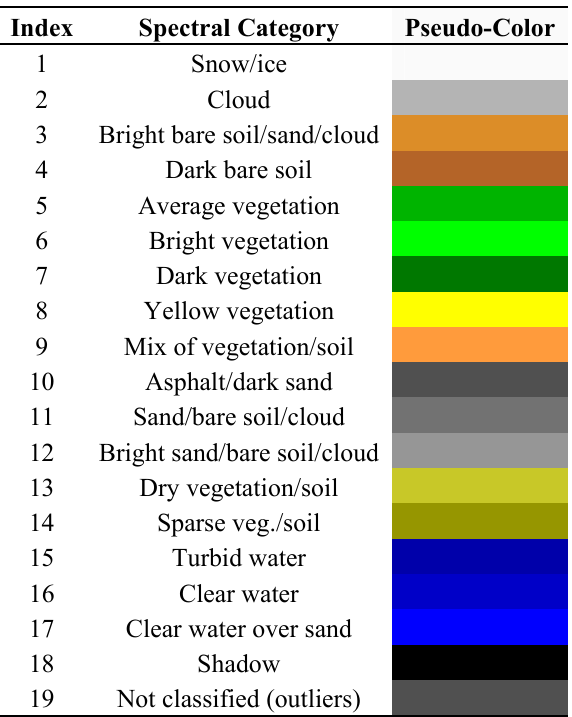
Table 2. Preliminary classification map legend adopted by the ATCOR™-SPECL single-granule pre-classifier and consisting of 19 spectral categories [6], refer to the Part 1, Table 2